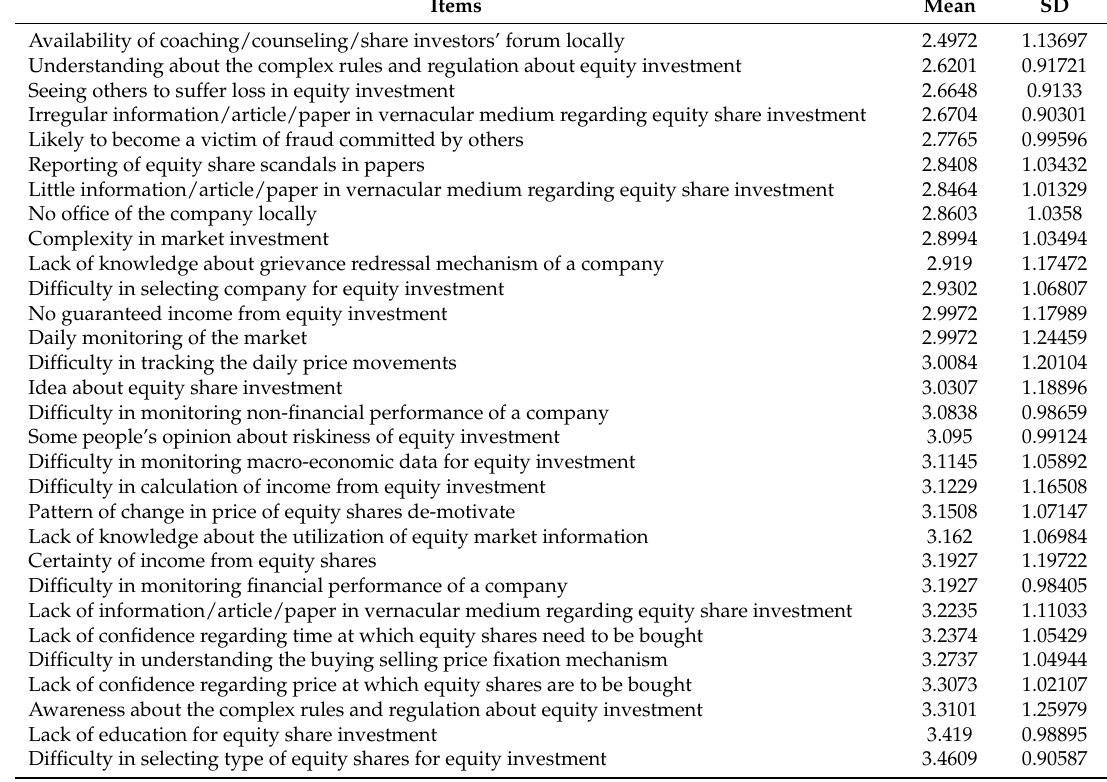
Table 3. Item Statistics.